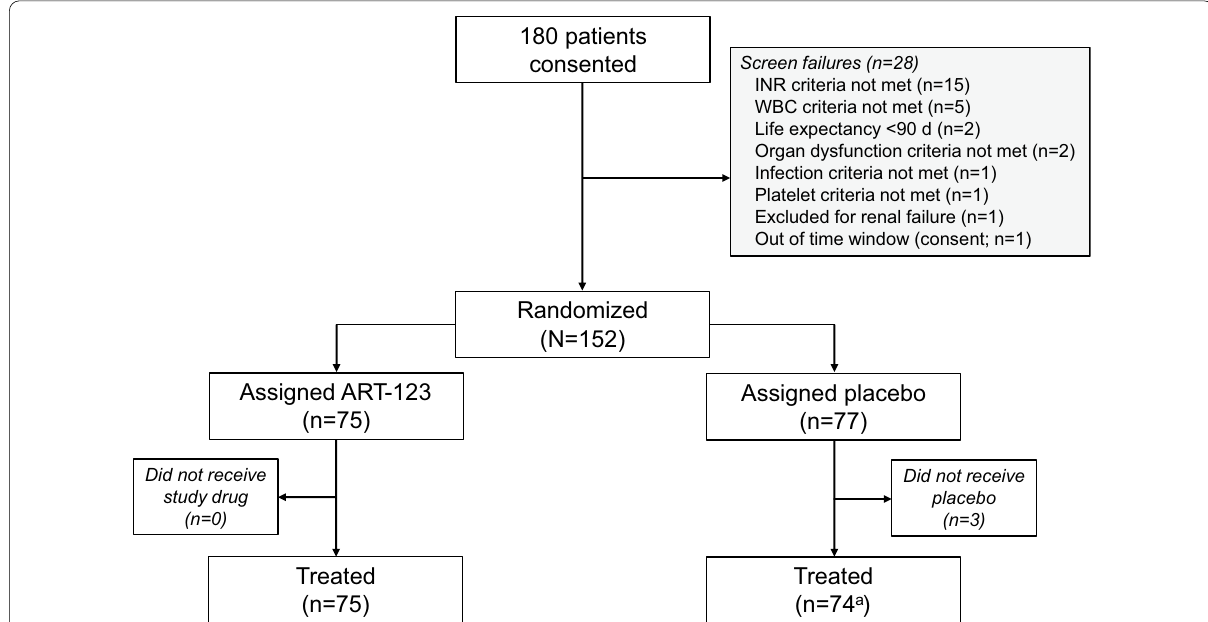
Fig. 1 Patient disposition for the SCARLET Study in France. INR, international normalized ratio; WBC, white blood cell. a One study patient randomized to the placebo group was administered a dose of ART‑123 in error; this patient is included in the ART‑1 23 group for safety